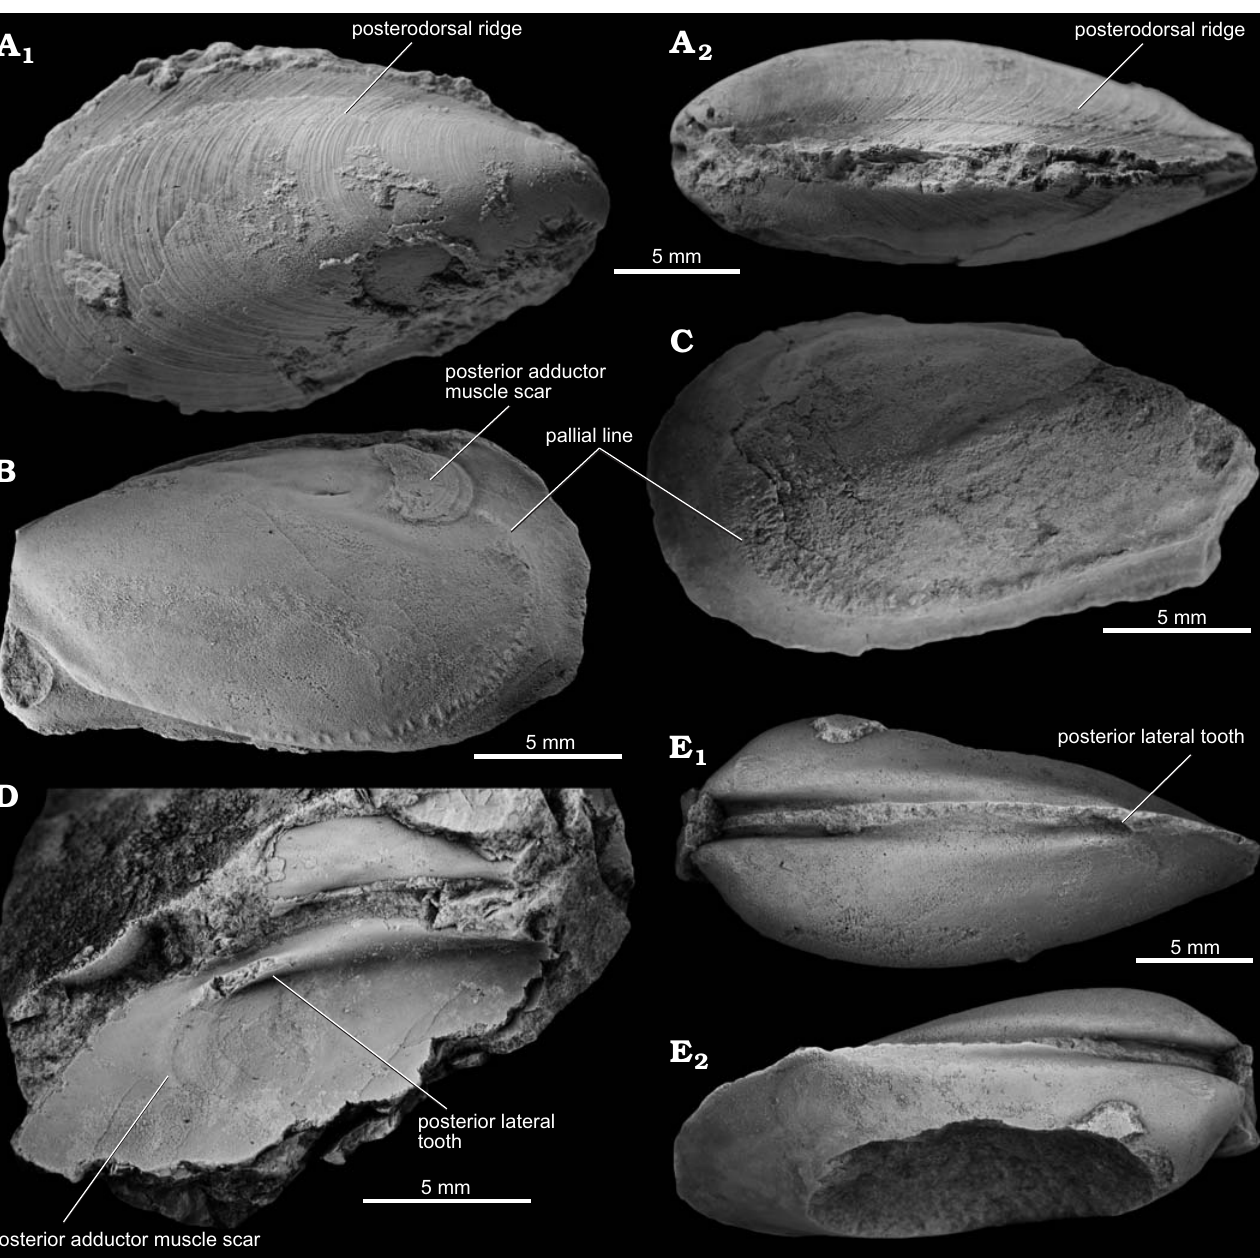
Fig. 3. The kalenterid bivalve Terzileria gregaria gen. et sp. nov. from the late Carnian, Late Triassic Terziler III seep deposit in southern Turkey. A . Mo184056, specimen with preserved shell showing irregular growth increments; right valve (A 1 ) and dorsal view (A 2 ). B . Mo184057, left valve of an internal mold, note mantle muscle scars along the pallial line. C . Mo184058, right valve of a specimen. D . Mo184059, shell fragment preserving the posterodorsal part of the inner shell surface of a left valve. E . Mo184060, internal mold showing the impression of the posterior lateral tooth in the left valve (E 1 ) and the lack of this feature in the right valve (E 2